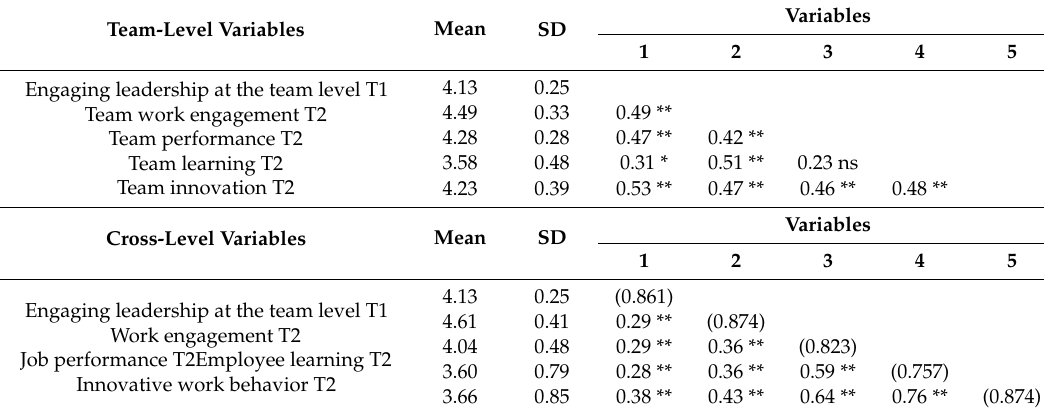
Table 3. Mean (M), Standard Deviation (SD), and Correlations of the Study Variables (Individual Level, N = 224, Team Level, N =